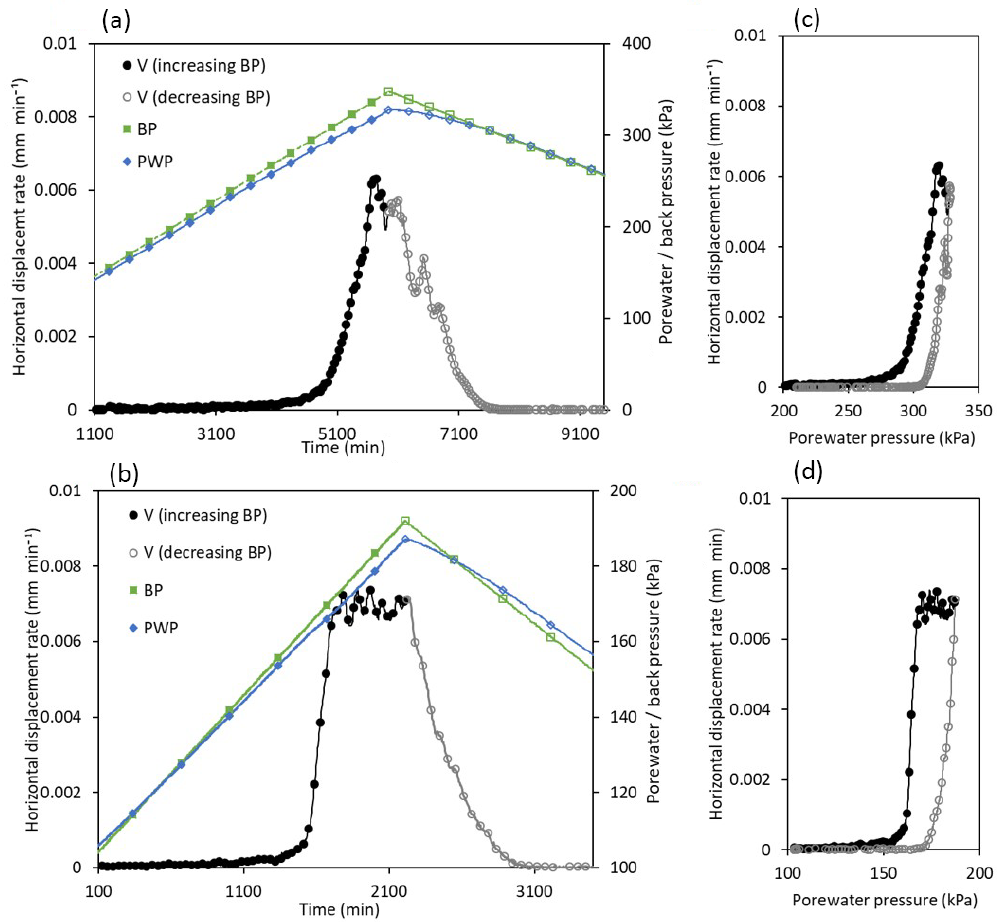
Figure 6. Relationship between shear surface displacement rate ( V ) and porewater pressure (PWP) during linear pore pressure reinflation ex- periments conducted at mean effective stresses of 400kPa (UTB PP1) and 150kPa (UTC PP1). (a) Horizontal displacement rate against time in relation to the applied back pressure (BP) and measured porewater pressure (PWP, experiment UTC PP1). (b) Horizontal displacement rate against time in relation to the applied back pressure (BP) and measured porewater pressure (PWP, experiment UTB PP1). (c) Displacement rate against porewater pressure, experiment UTB PP1. (d) Displacement rate against porewater pressure, experiment UTC